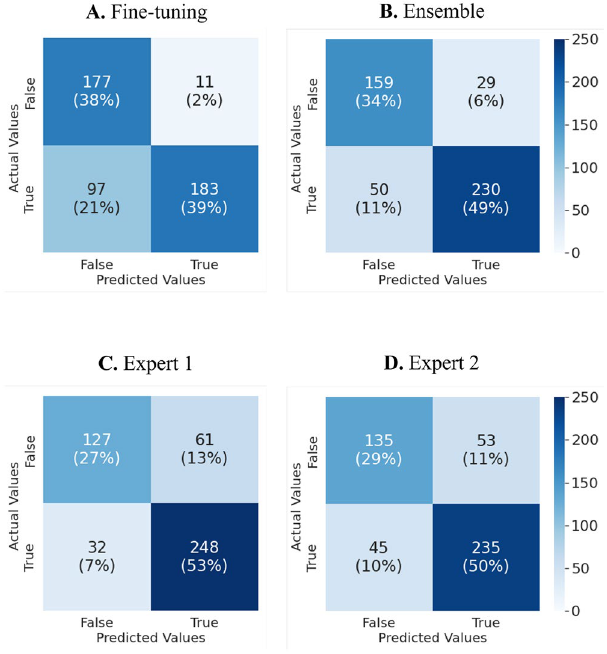
Figure 7. Confusion matrices of the single fine-tuning model ( A ), the ensemble model ( B ), and the two human experts ( C,D